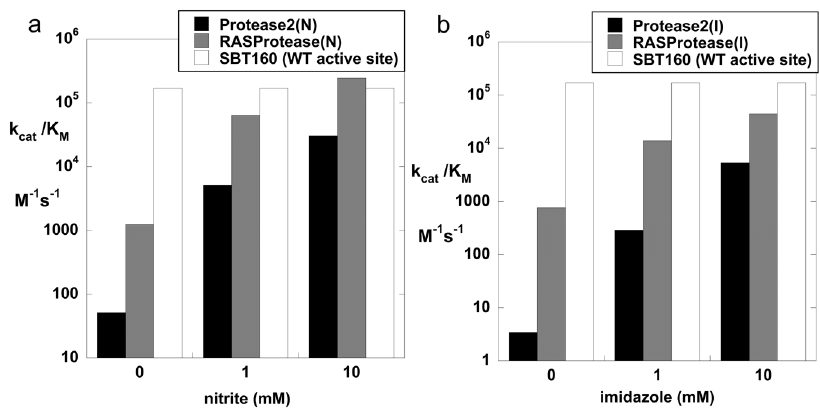
Fig. 3 k cat / K M for the target substrate QEEYSAM-AMC as a function of cofactor. a Protease2(N) and RASProtease(N) vs. nitrite concentration. b Protease2(I) and RASProtease(I) vs. imidazole concentration. The activity of a progenitor protease (SBT160) with a complete catalytic triad (D32, H64, S221) is shown for comparison.